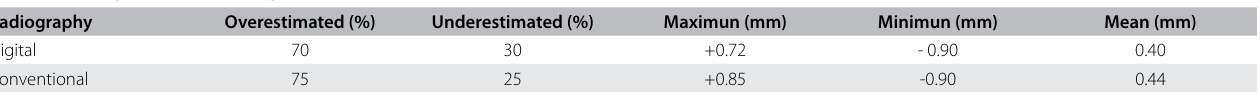
sd: standard deviation; *Diferença estatística. Table 2. Percentage of overestimated and underestimated radiographic tooth lengths as well as maximum, minimum and mean discrepancies from the actual tooth lengths for each radiographic method